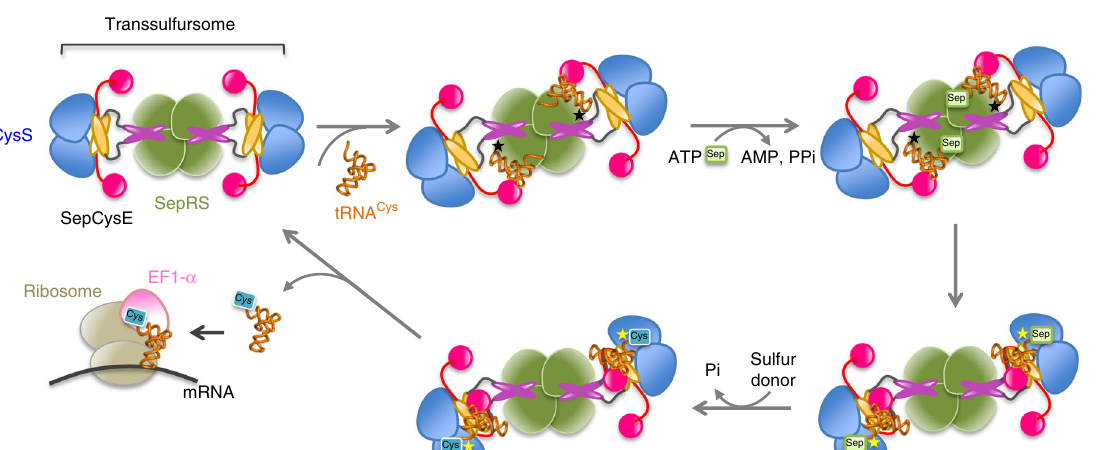
carries tRNA Cys from the fi rst active site to the second site (Fig. 5a). At fi rst, tRNA Cys bound to SepCysE(CTD) binds to the active site of SepRS while SepCysE(N-helix) remains fi xed to SepRS. The model building shows such complex is possible by extending the two linkers of SepCysE (Fig. 5a, left). This is con- sistent with the experiment that SepCysE enhances the binding of SepRS and tRNA Cys 11 . After Sep is attached at the fi rst reaction site, CCA terminus of the tRNA Cys leaves from the active site (Fig. 5a, middle) and rotates with the SepCysE(CTD) to reach binding site of SepCysS. The structure of the present ternary complex shows the structure at this stage. SepCysS recognizes the discriminator base U73, and possibly Sep moiety of tRNA Cys , and the tRNA Cys separates from the anticodon recognition region of